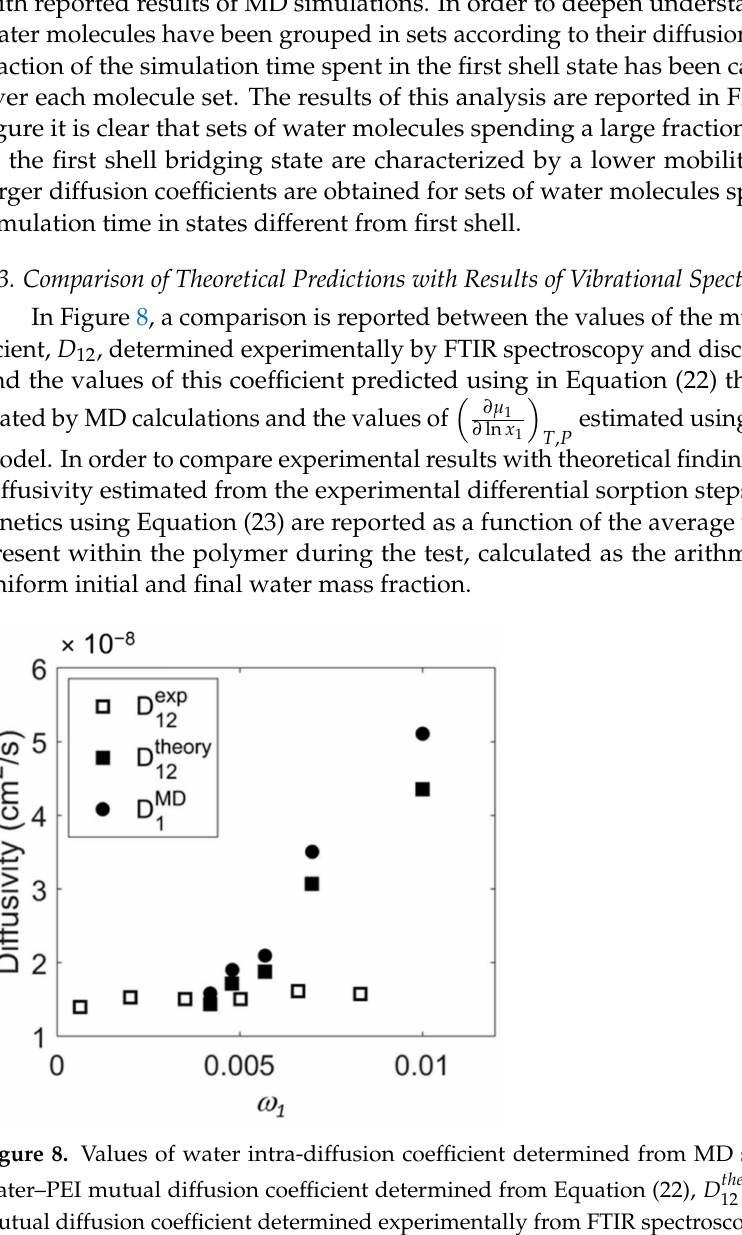
, of 1 , and of water–PEI 12 1